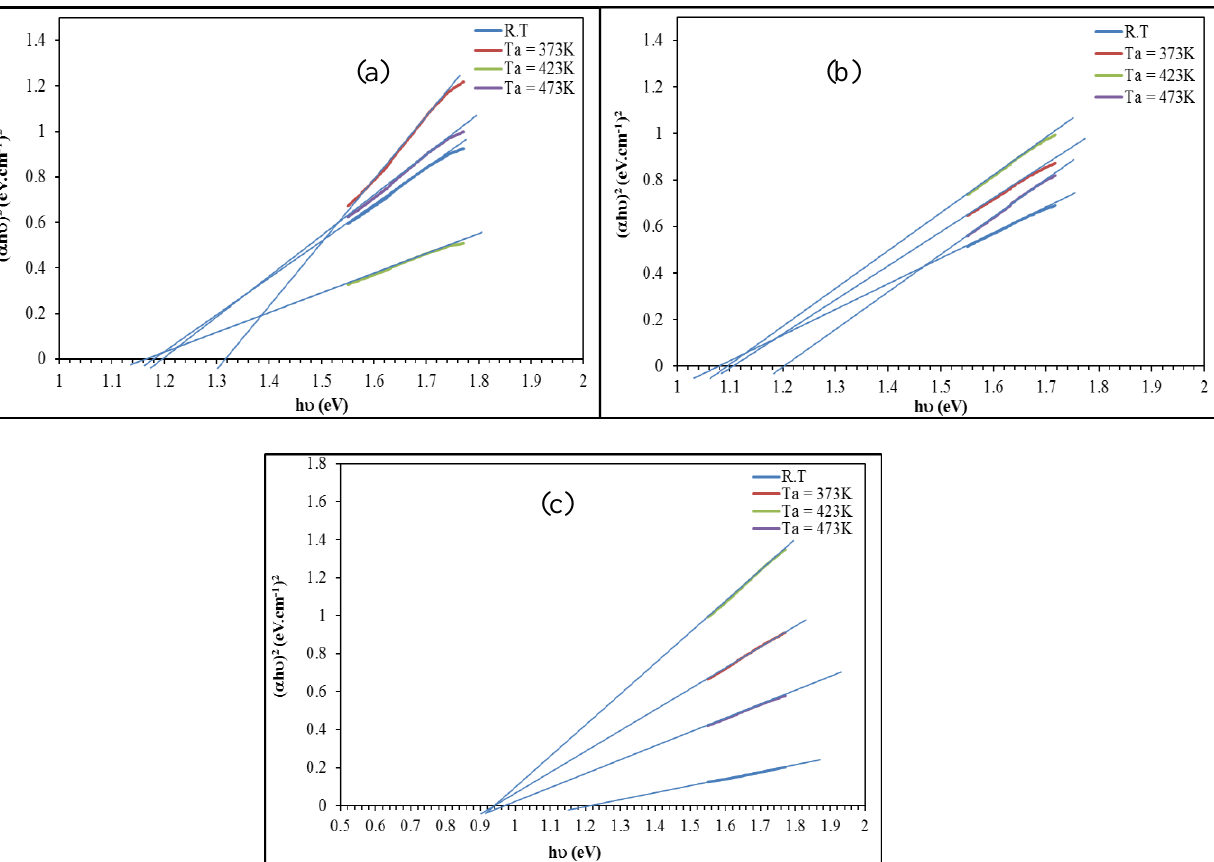
Fig. 3: (αhʋ) 2 versus photon energy of incident radiation for as-deposited and annealed thin films (Q-band) of NiPc/C blends with three different ratios of C 60 (b) (100/10), and (c)